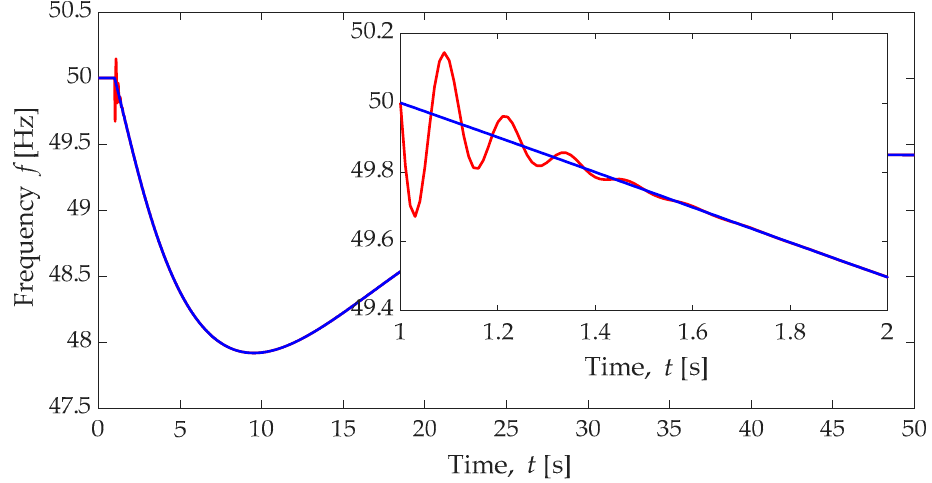
Figure 15. Frequency response ( f in Hertz) in a single area power system considering high sampling frequency measurement where the high-speed oscillation of the frequency response is capture (red colour) and relatively low sampling frequency (blue colour).